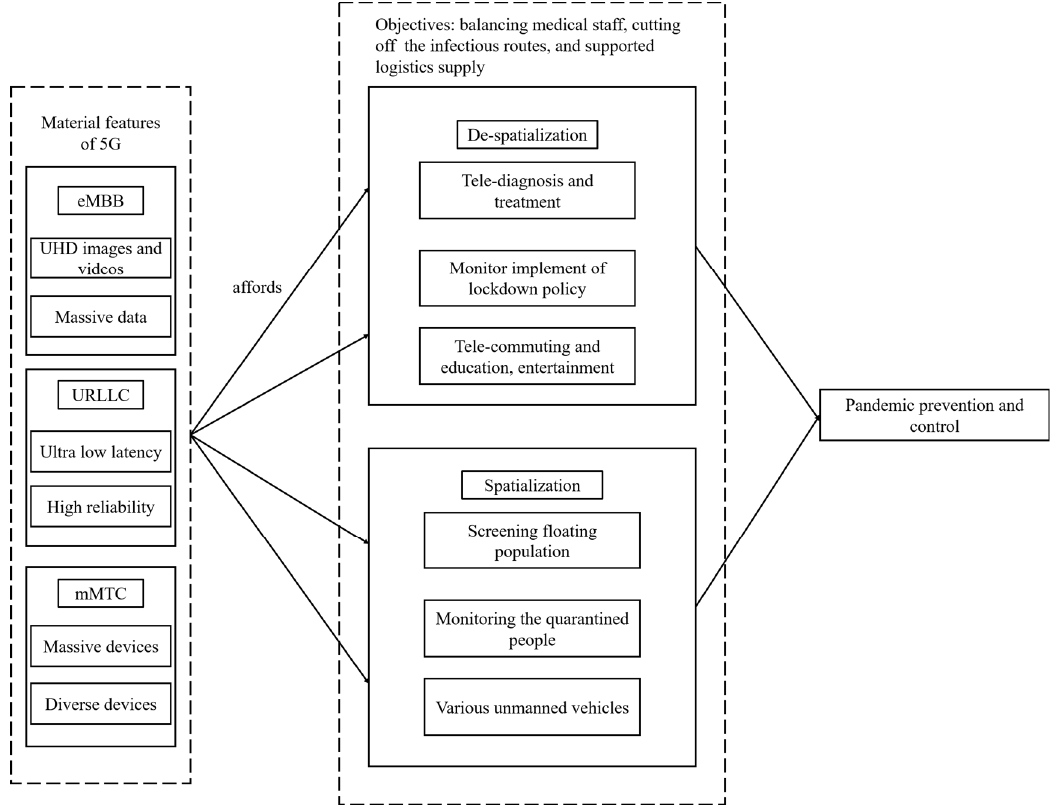
Figure 2. The model of 5G that enabled the pandemic prevention and control.